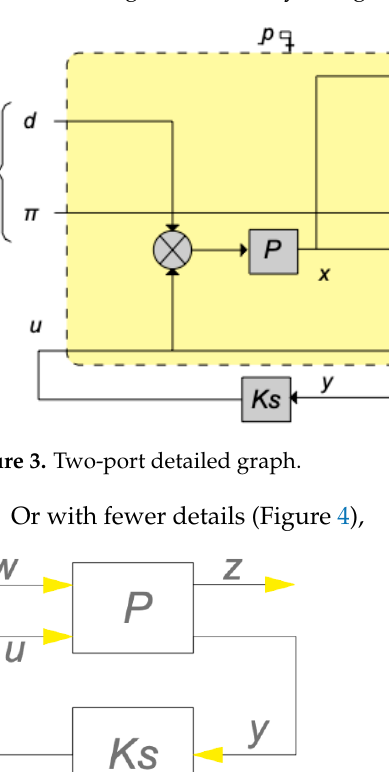
Figure 4. Two-port graph.